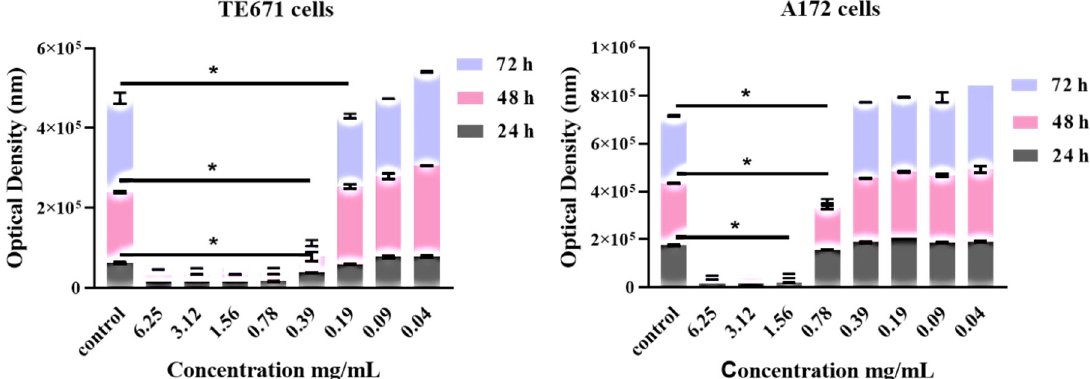
Figure 1. Dose-dependent and time-dependent effect of R. officinalis extract on TE671 ( A ) and A172 ( B ) cells. Data are presented as the mean ± standard error of the mean (SEM) ( n = 8). The asterisk (*) indicates significant differences between untreated and treated cells. The grey color corresponds to 24 h of treatment, the pink to 48 h and the light blue to 72 h.